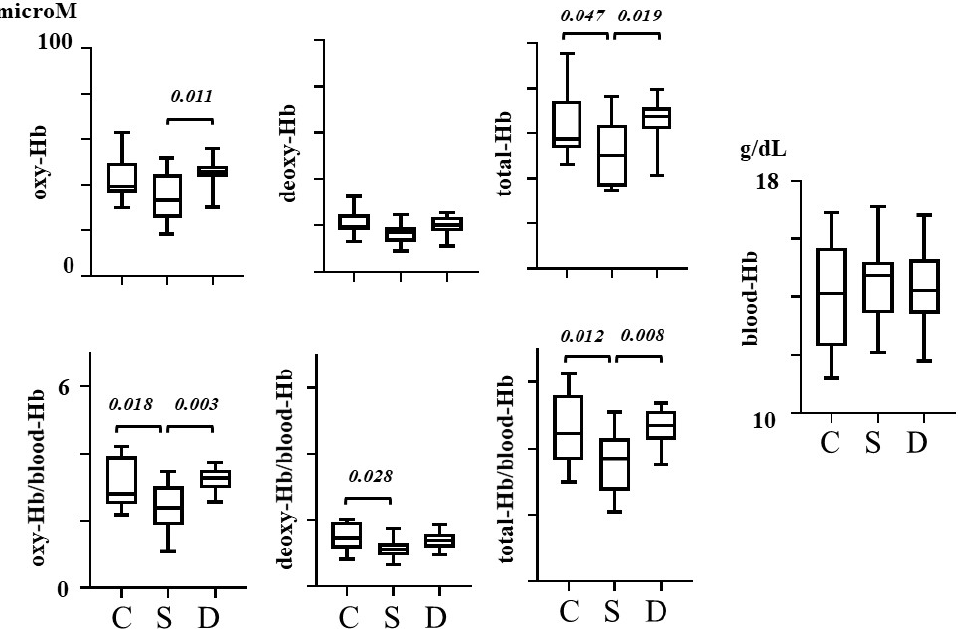
Figure 1. Box plot presentation of the data in control (C), schizophrenia (S), and depression (D) groups with p -values of Tukey’s multiple comparison test. Horizontal lines connecting two groups indicate the statistically significant difference between the data averages. p -values of Tukey’s multiple comparison test are shown above the line.